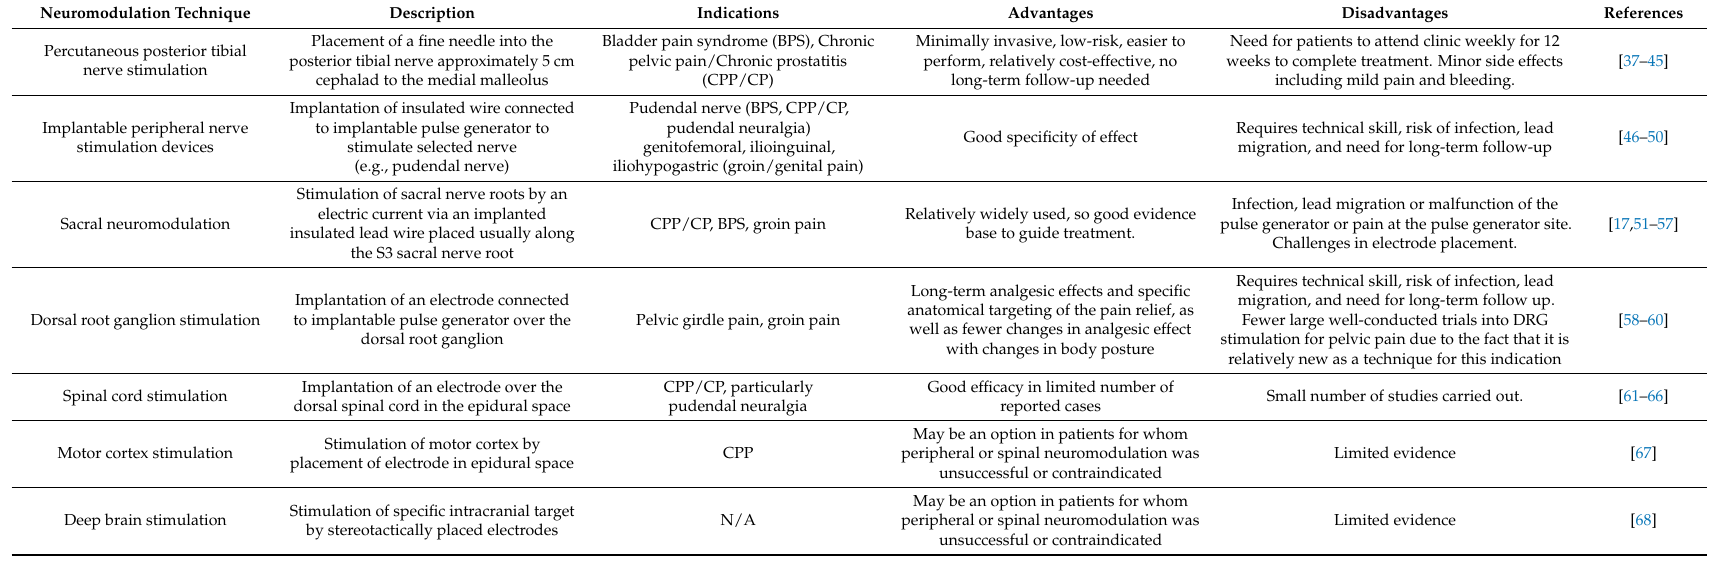
Table 1. Summary of types of neuromodulation technique and application for pelvic